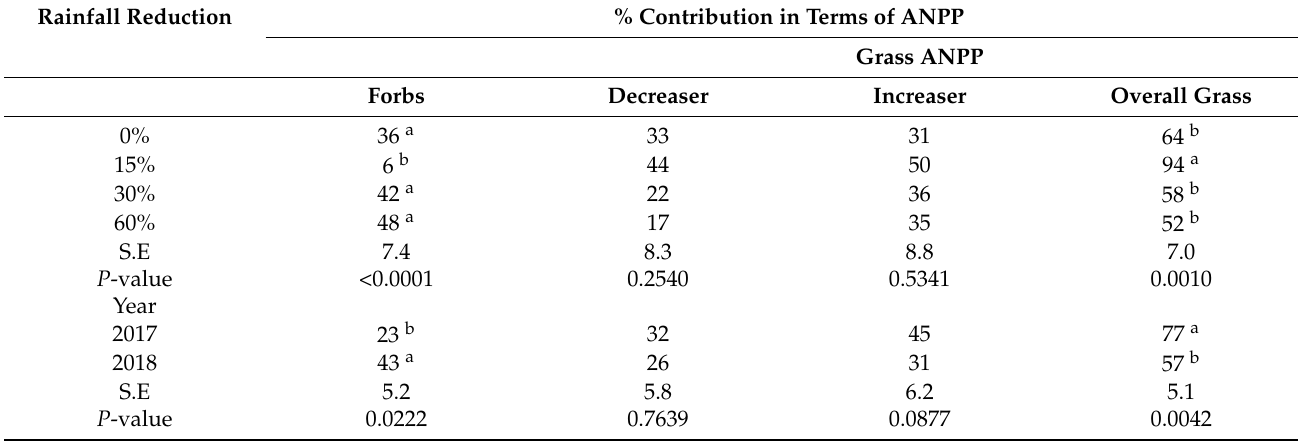
Table 3. Percentage (%) contribution of different functional groups in terms of annual primary productivity (ANPP) as affected by intensity of rainfall reduction (RR) in Pretoria.